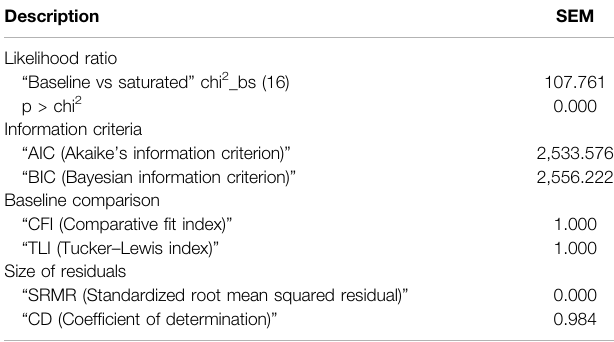
TABLE 4 | Goodness-of- fi t tests for the SEM